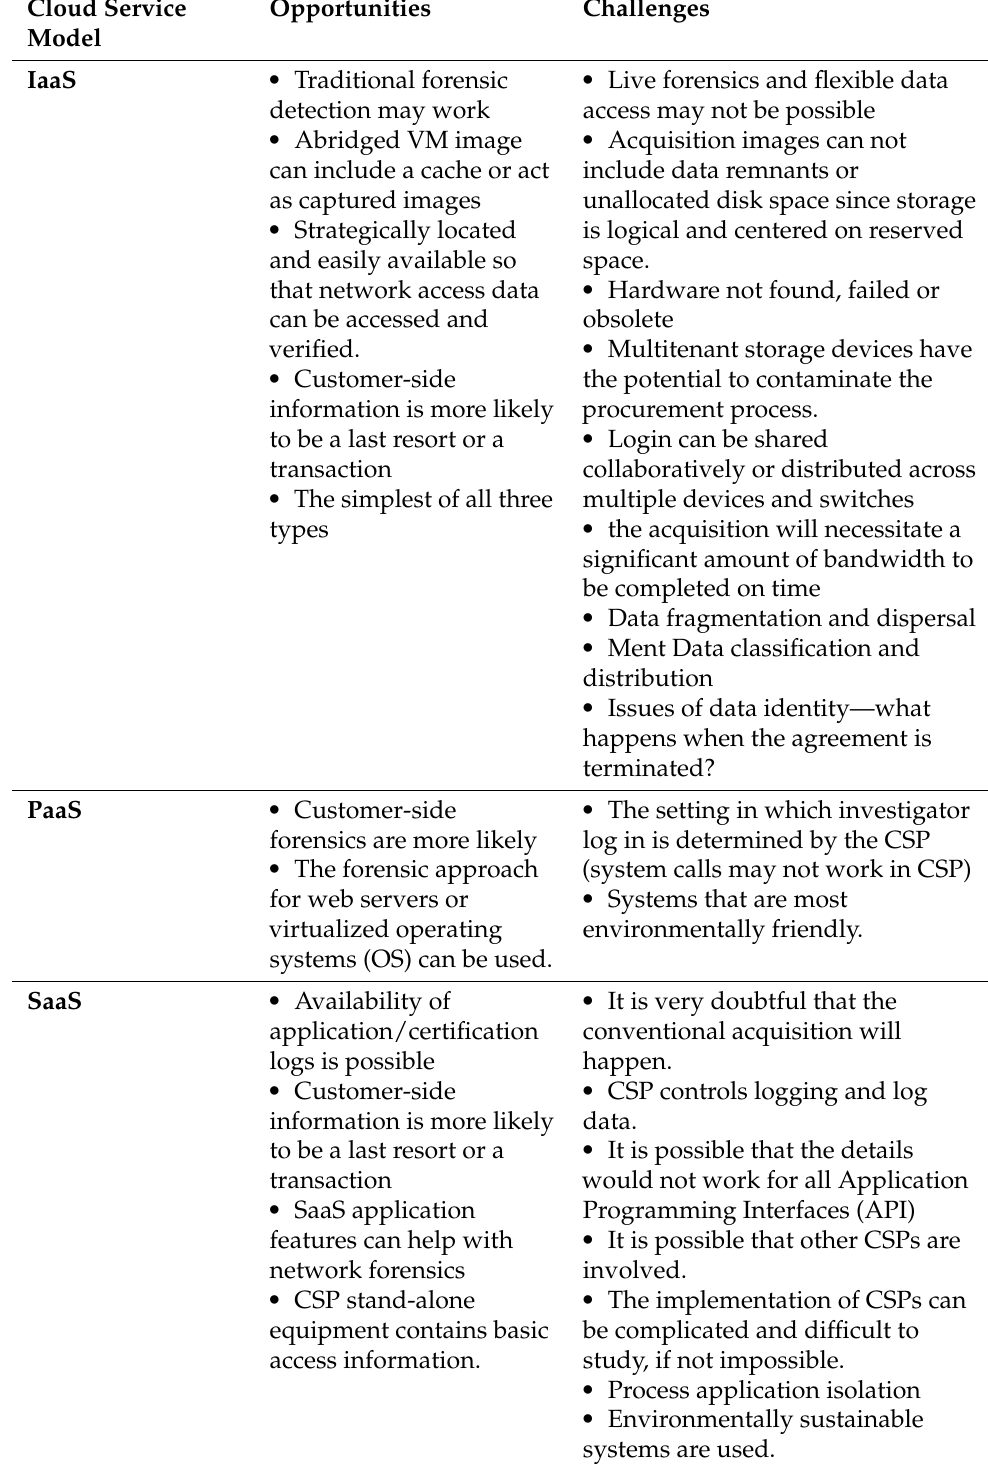
Table 5. Cloud service models and associated challenges